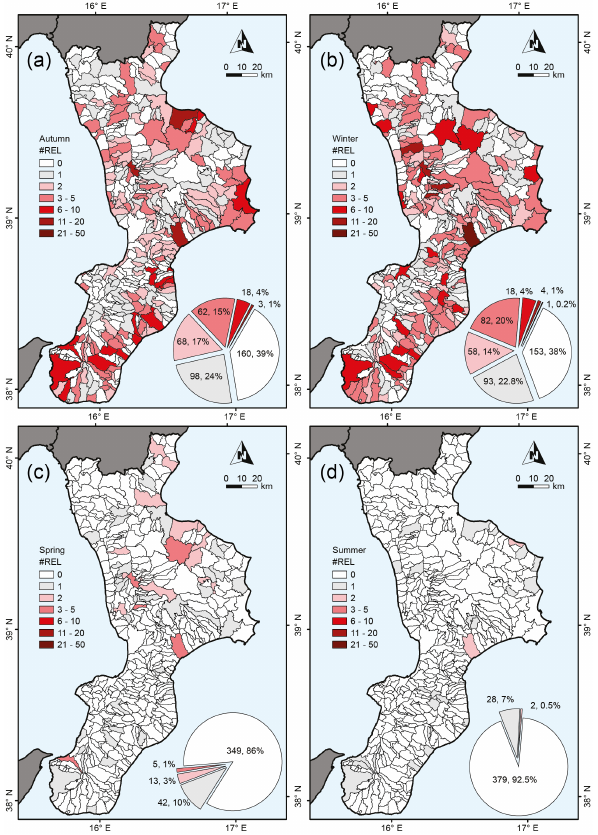
Figure 4. Maps show the number of rainfall events with land- slides (#REL) per municipality in Calabria in the (a) Autumn (22 September–20 December), (b) Winter (21 December–20 March), (c) Spring (21 March–20 June), and (d) Summer (21 June–21 September). Pie charts show number and percentage of municipali- ties in each seasonal class.